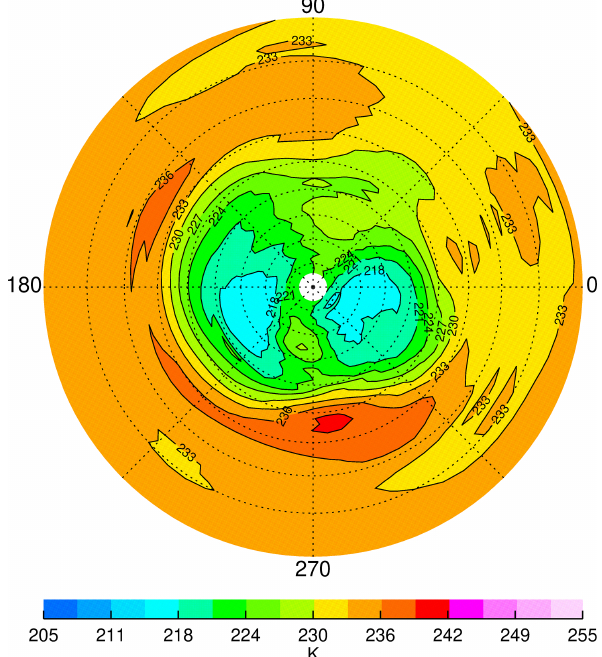
Figure 11. V6 temperature at 10hPa for 15 March 1979 in the NH; contour interval is 3K.